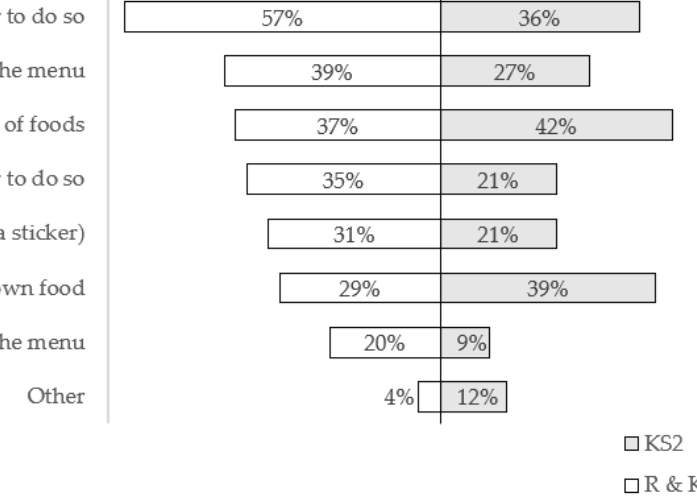
Figure 2. Parents’ perspectives on what might help their children choose a different school lunch option from the school menu, n = 84, % of parents of younger children (R & KS1; ages 4–7 years) and % of parents of older children (KS2; ages 7–11 years), separately. Table 3. Emerging themes and subthemes from analysis of parents’